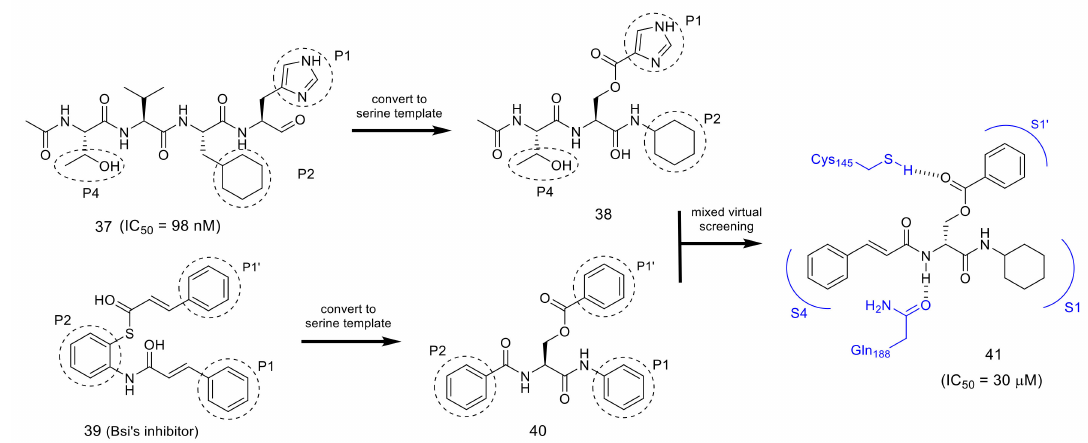
Figure 12. Design of the serine derivative as a nonpeptide inhibitor for SARS-CoV 3CL pro.